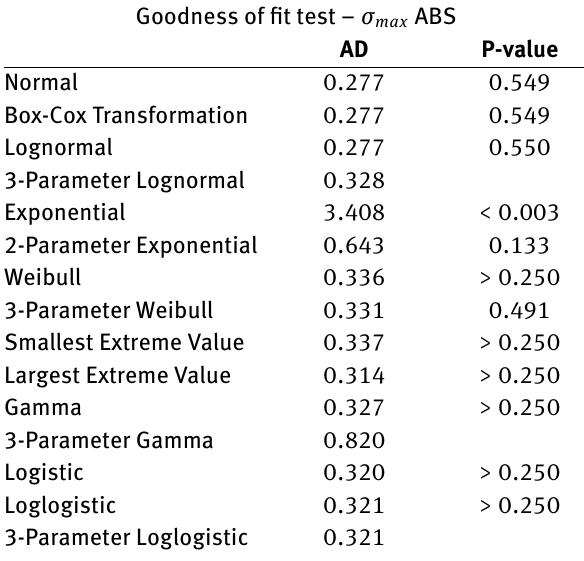
Table 9: Individual distribution identification for the ABS